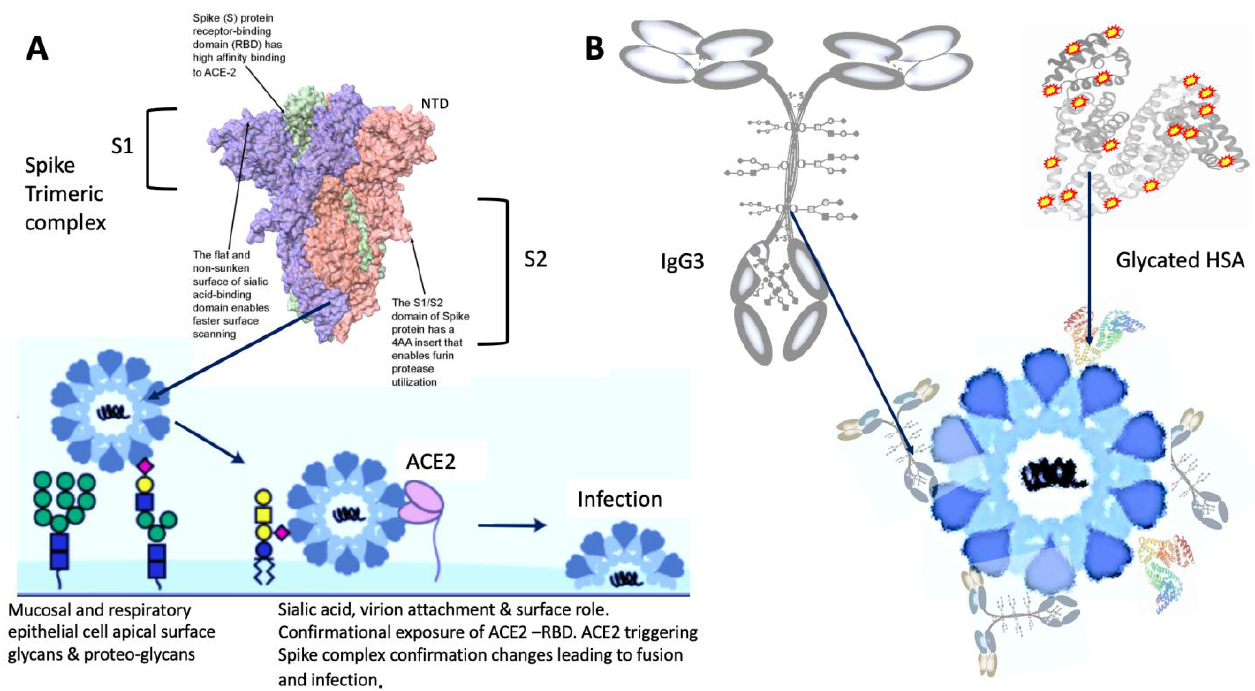
Figure 4. Spike protein sialic acid glycan binding (S1 subunit NTD-domain) role in ( A ) mucosal epithelial attachment and infection of respiratory cells and ( B ) potential role in binding IgG3 at the neck region and AGE glycated HSA, during viremia, thereby aiding immune evasion and deposition of reactive complex that may give rise to vascular pathologies.